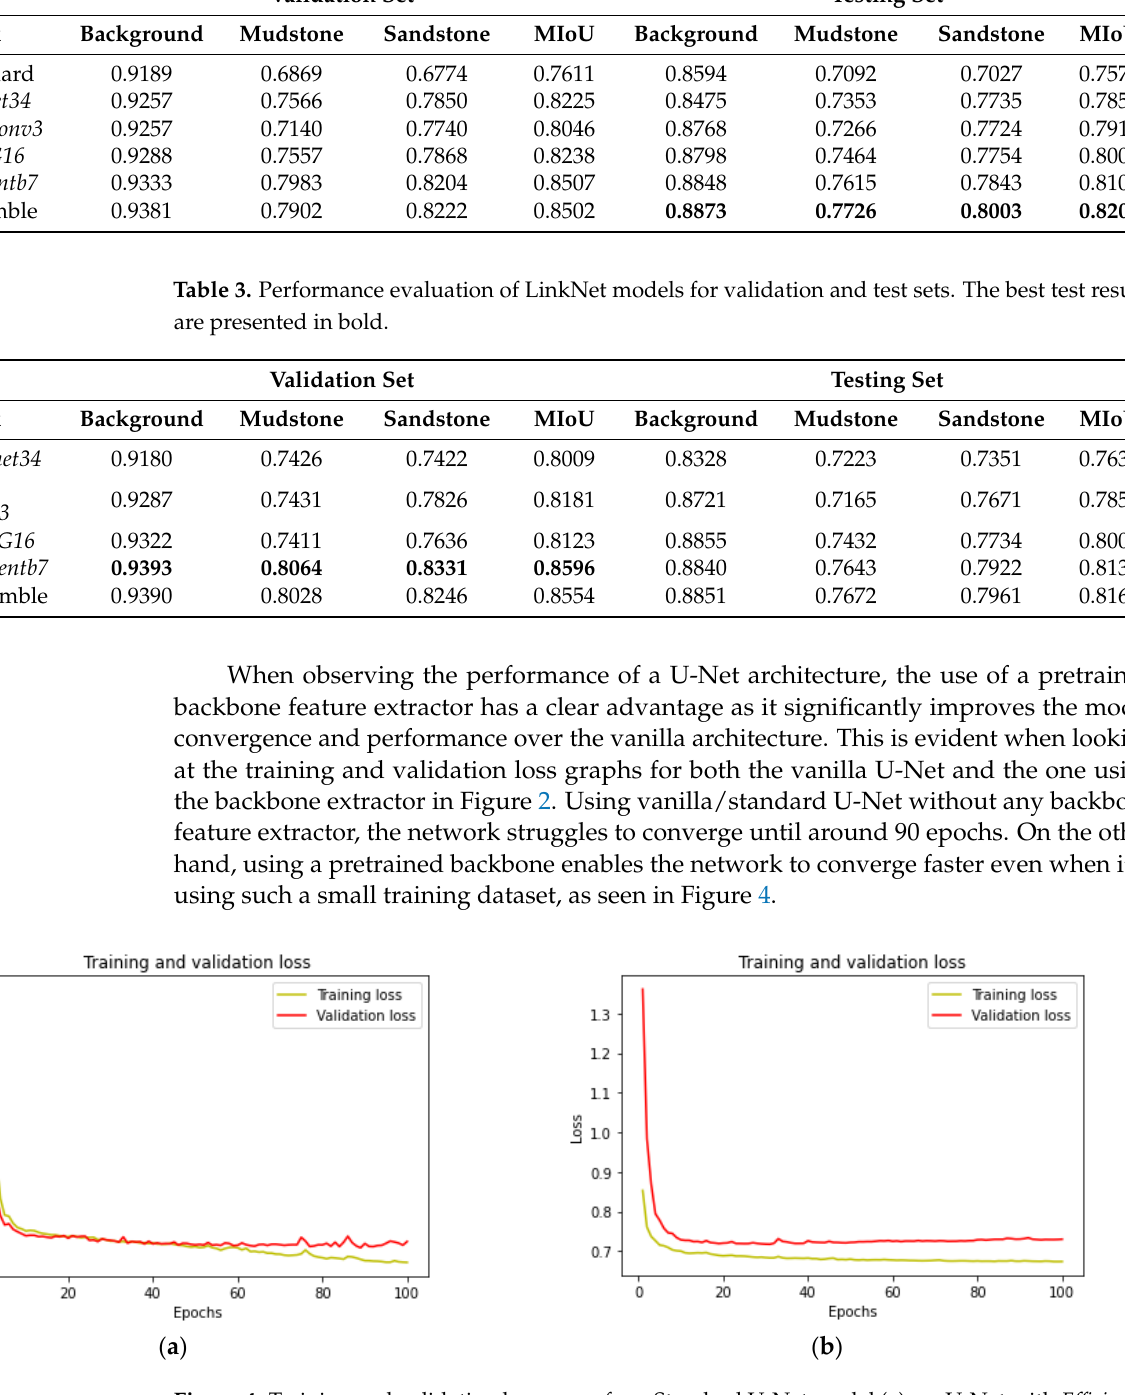
Figure 4. Training and validation loss curve for a Standard U-Net model ( a ) vs. U-Net with Efficientb7 encoder ( b ).